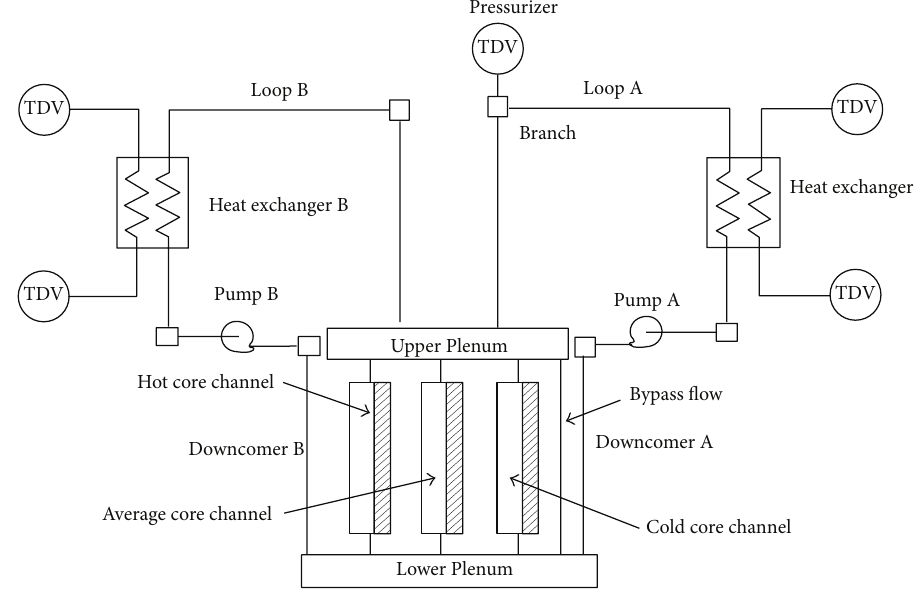
Figure 6: Scheme of the TMI PWR benchmark.